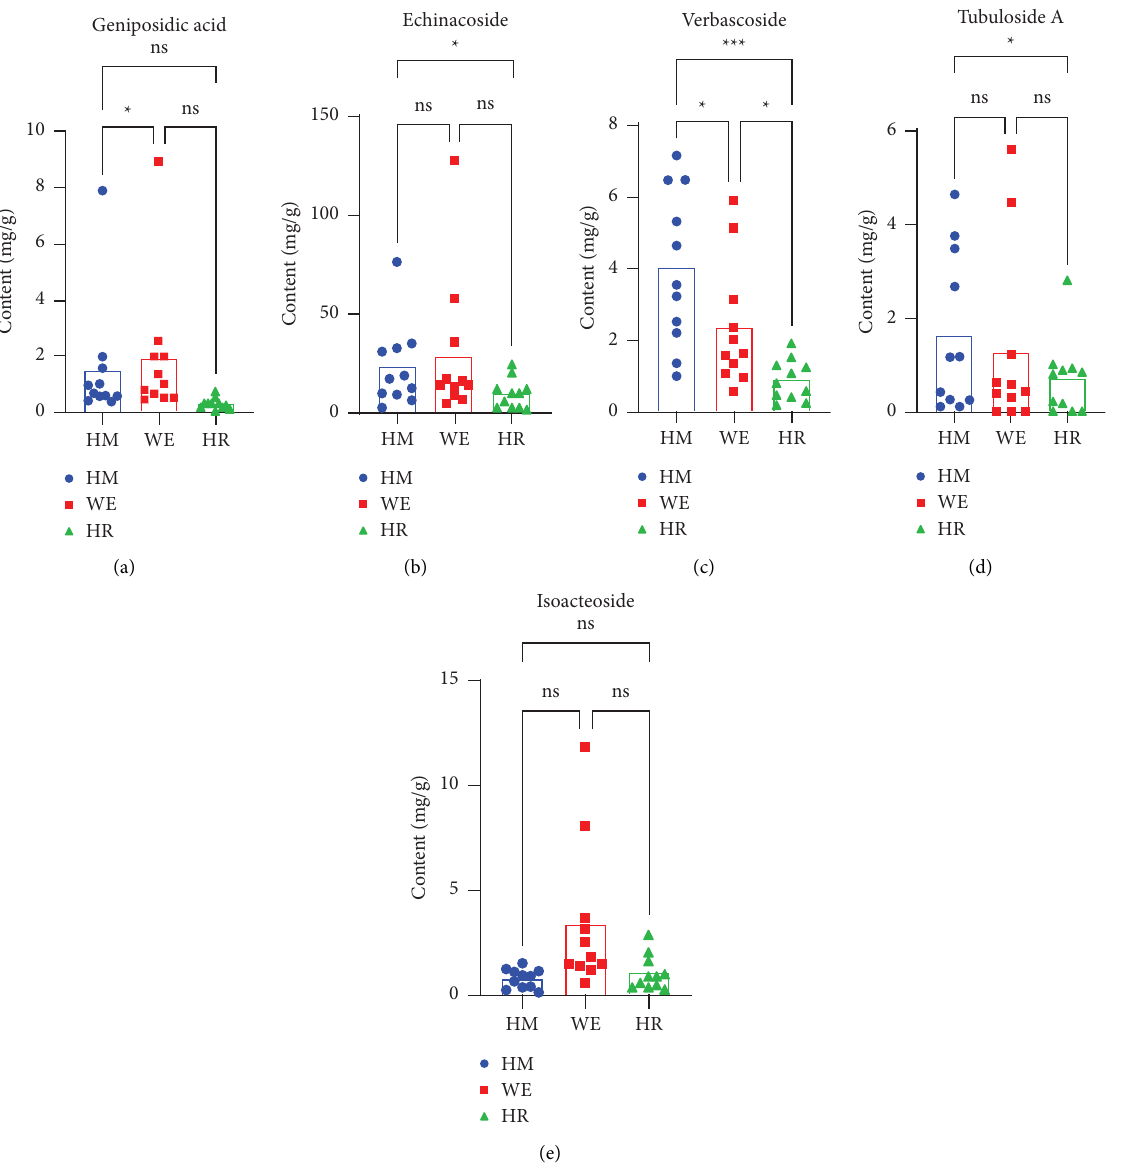
Figure 4: Content determination of fve components from diferent forms ( n � 11). ∗ p < 0 . 05, ∗∗∗ p < 0 . 001, ns: not signifcant. Table 3: Similarities of HM-WE, HM-HR, and WE-HR for 11 batches of C. tubulosa .